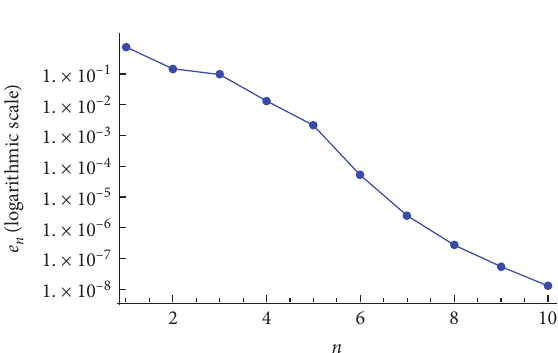
Figure 8: e m � 3 (Example n on logarithmic scale for